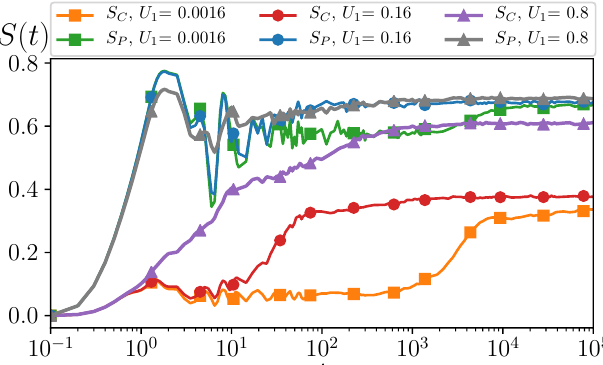
( t ) and Figure 12: Time evolution of the configurational entanglement entropy S C ( t ) for N = 7 spinless fermions on K = 14 of the particle entanglement entropy S P sites with quasirandom disorder. The parameters are U = 0 and W = 8. The results are averaged over the phase φ in the interval [ 0,2 π ] , the initial state is a Fock state with random site occupation and N =